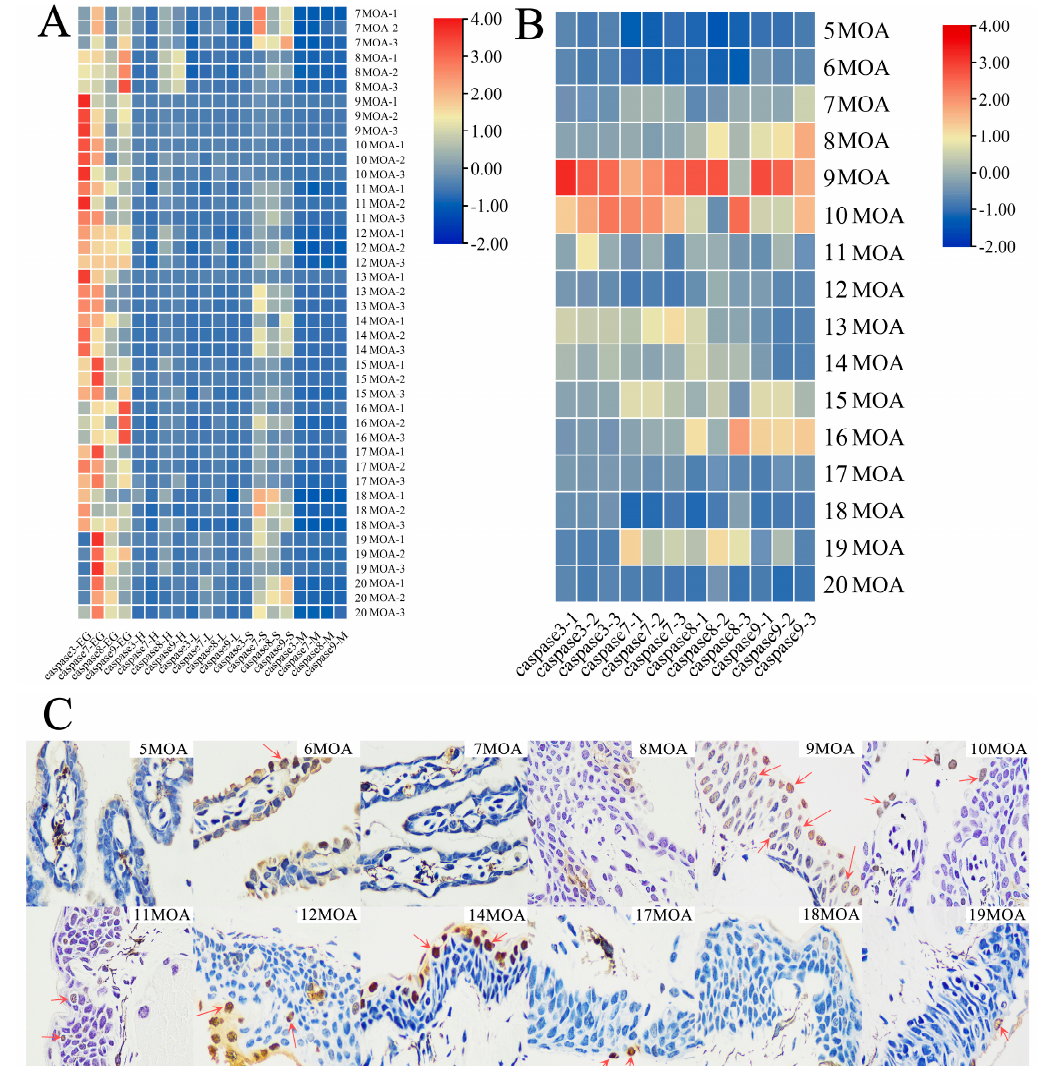
Figure 4. ( A ) The expression patterns of tissue distribution in the Chinese giant salamander caspase 3/7/8/9 genes . EG: external gill; H: heart; L: liver; S: skin; M: muscle. ( B ) The expression patterns of caspase 3/7/8/9 genes in the external gill of the Chinese giant salamander at different MOAs. ( C ) Apoptosis in the external gill of a Chinese giant salamander during metamorphosis, as seen using a TUNEL assay (400×). Red arrows indicate TUNEL-positive cells.